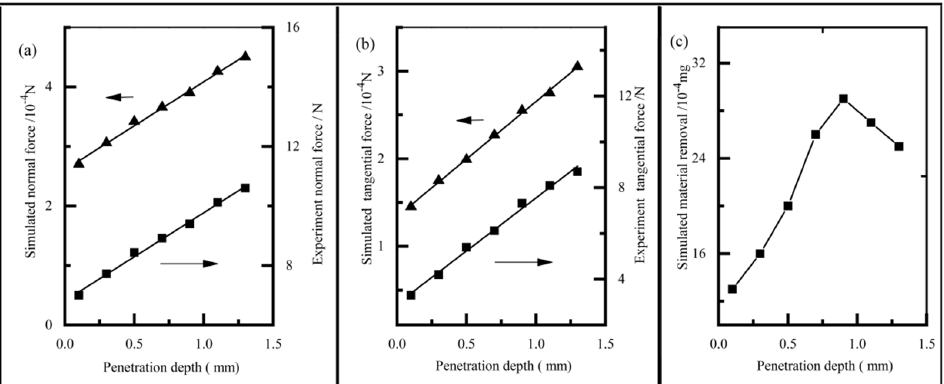
Figure 11. The effect of penetration depth on the normal force ( a ); tangential force ( b ); and material removal ( c ).